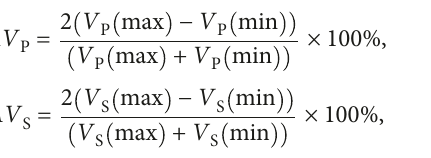
Figure 8: The relation between CT image threshold and anisotropic value from di ff erent